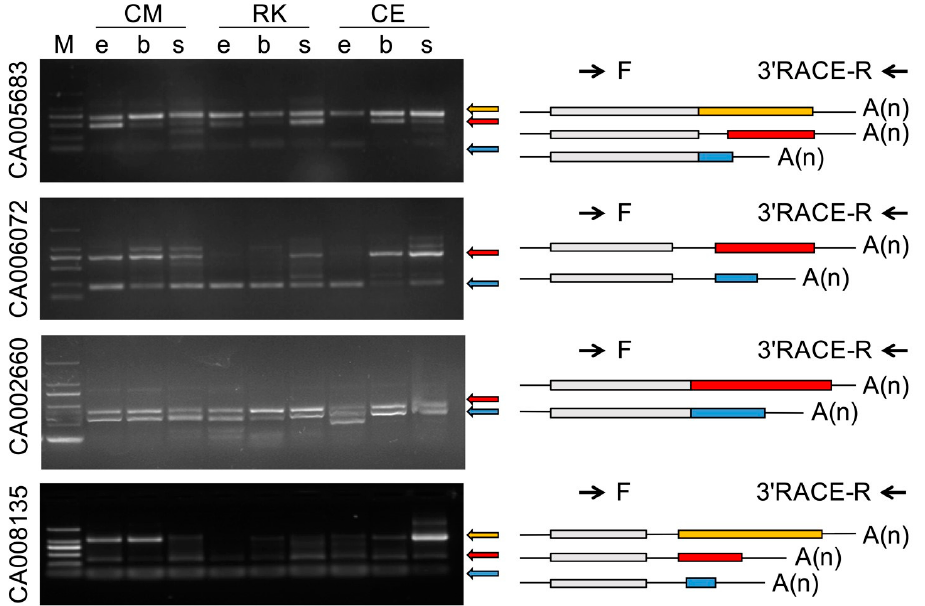
Figure 4. Alternative polyadenylation verification by 3’RACE. CM, RK, and CE represent Common, Ryukin, and Celestial-Eye goldfish, respectively. e: 30% epiboly stage, b: bud stage, s: 14-somite stage. F and 3’RACE-R represent forward and reverse primers used for 3’RACE.